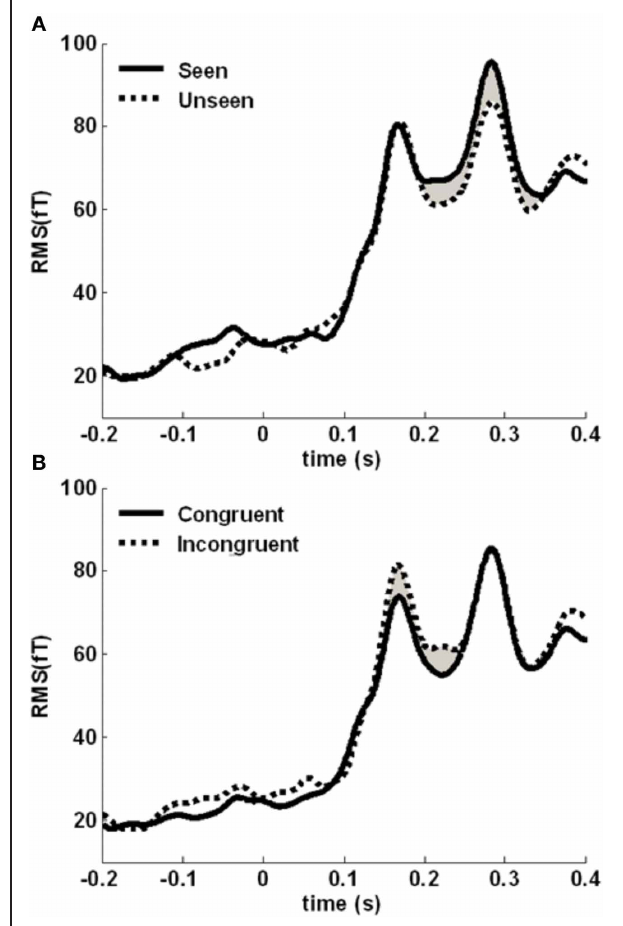
FIGURE 5 | Time course of the awareness and congruency effects. (A) Root-mean square (RMS) of the target-evoked response, averaged across the awareness-related cluster, separately for seen (solid line) and unseen (dotted line) gratings. The difference is maximal between 190 and 350ms (shaded area). (B) Averaged RMS across the congruency-related cluster, separately for congruent (solid line) and incongruent (dotted line) trials. The difference is maximal between 150 and 250ms (shaded